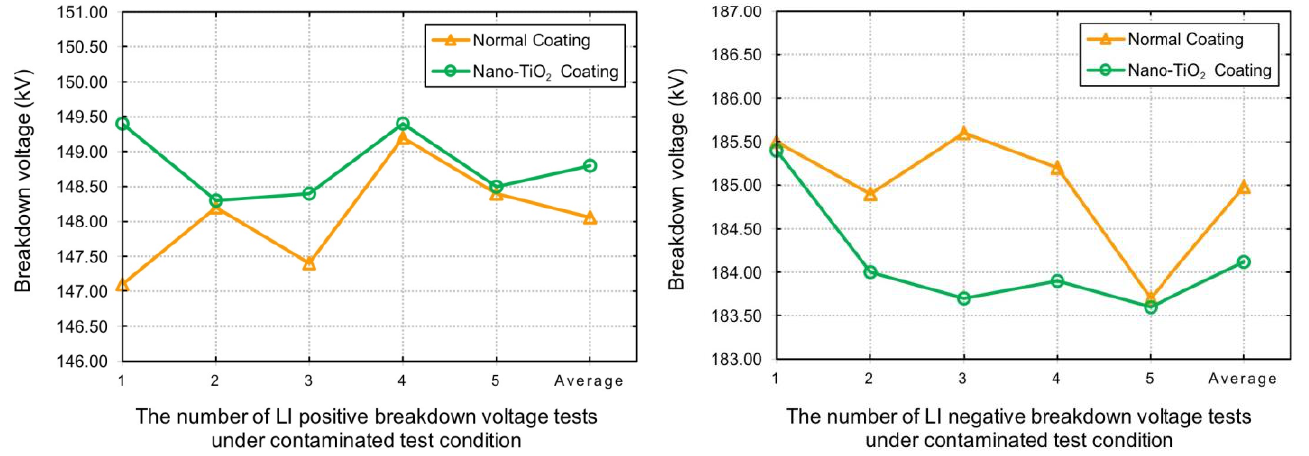
Figure 12. Test results of critical impulse flashover voltage value under contaminated test conditions are as follows. ( a ) The lightning impulse critical-flashover voltage performance under positive polarity testing; ( b ) The lightning impulse critical-flashover voltage performance under negative polarity testing.